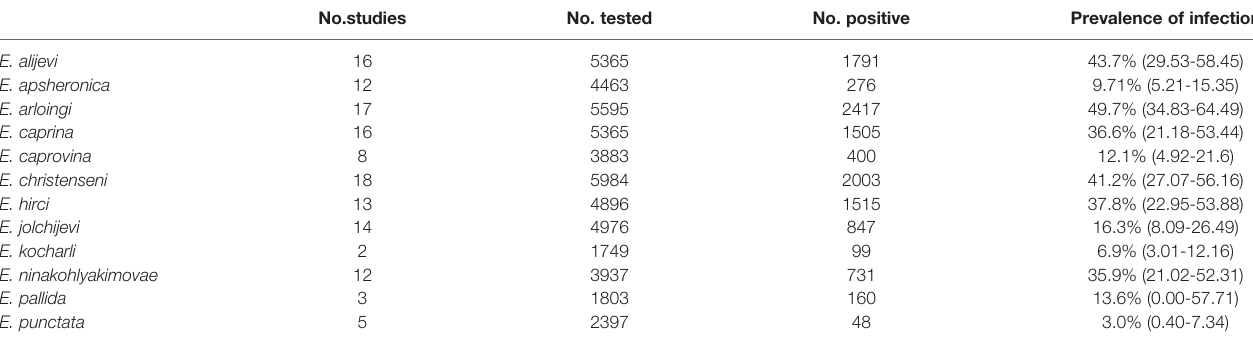
TABLE 4 | Estimates of Eimeria spp. prevalence in goats in China.